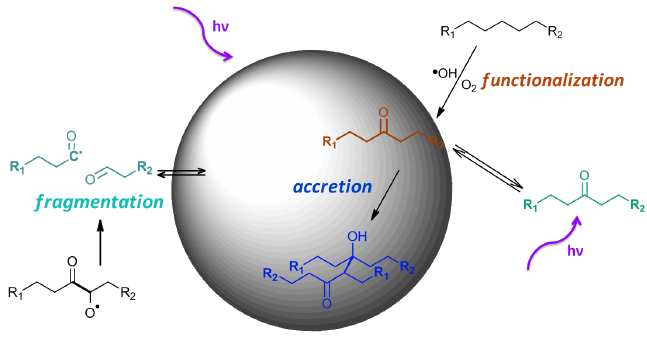
Fig. 1. Major mechanisms in gas and aerosol-phase oxidation. The three major chemical mechanisms that a carbon backbone undergoes in the atmosphere are represented along with their interaction with aerosols. They are described and revised in Kroll and Seinfeld (2008) and Rudich et al. (2007). Both, functionalization and accretion tend to decrease the vapor pressure of species by either adding polarity to the molecule or by accreting with other molecules. Fragmentation cleaves carbon-carbon bonds of molecules, generally increasing the vapor pressure of products; however, a good exception is the ozonolysis of monoterpenes, where both fragmentation and functionalization happen simultaneously, adding polarity and decreasing the overall vapor pressure of the products. The competition of these three mechanisms define the fate of molecules in the atmosphere, but it is not clear how this competition plays out while molecules and particles age.